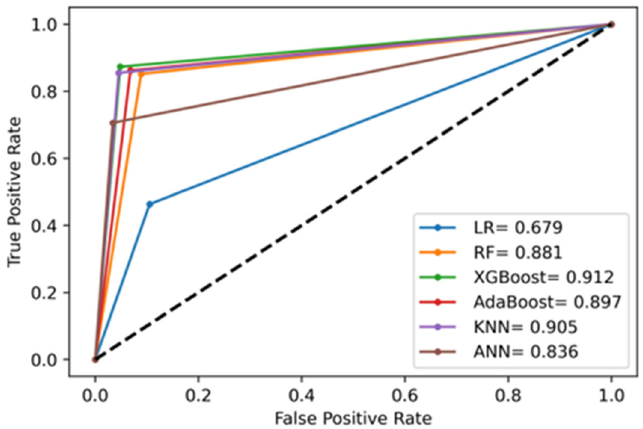
Figure 7. AUCs of various classifiers that diagnose COVID-19.